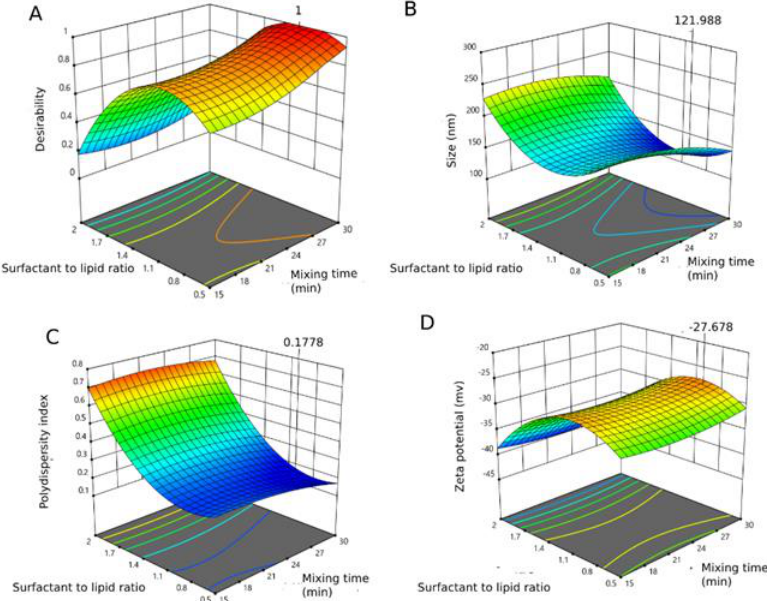
Figure 2. The three-dimensional surface of the desirability function at the factor space ( A ). Individual response is graphed to show the optimum point. Particle size (nm) ( B ), polydispersity index ( C ) and zeta potential (mV) ( D ). Table 5. Predicted and observed values of the physicochemical characteristics of the optimized tadalafil-loaded niosomes.